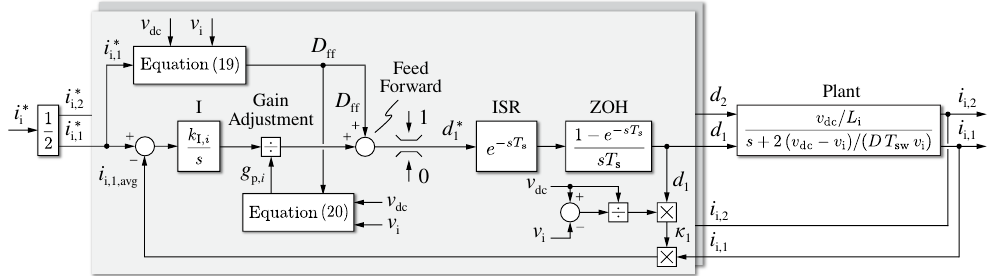
Figure 8. Detailed block diagram of the two identical PFC current ( i i,1 , i i,2 ) control